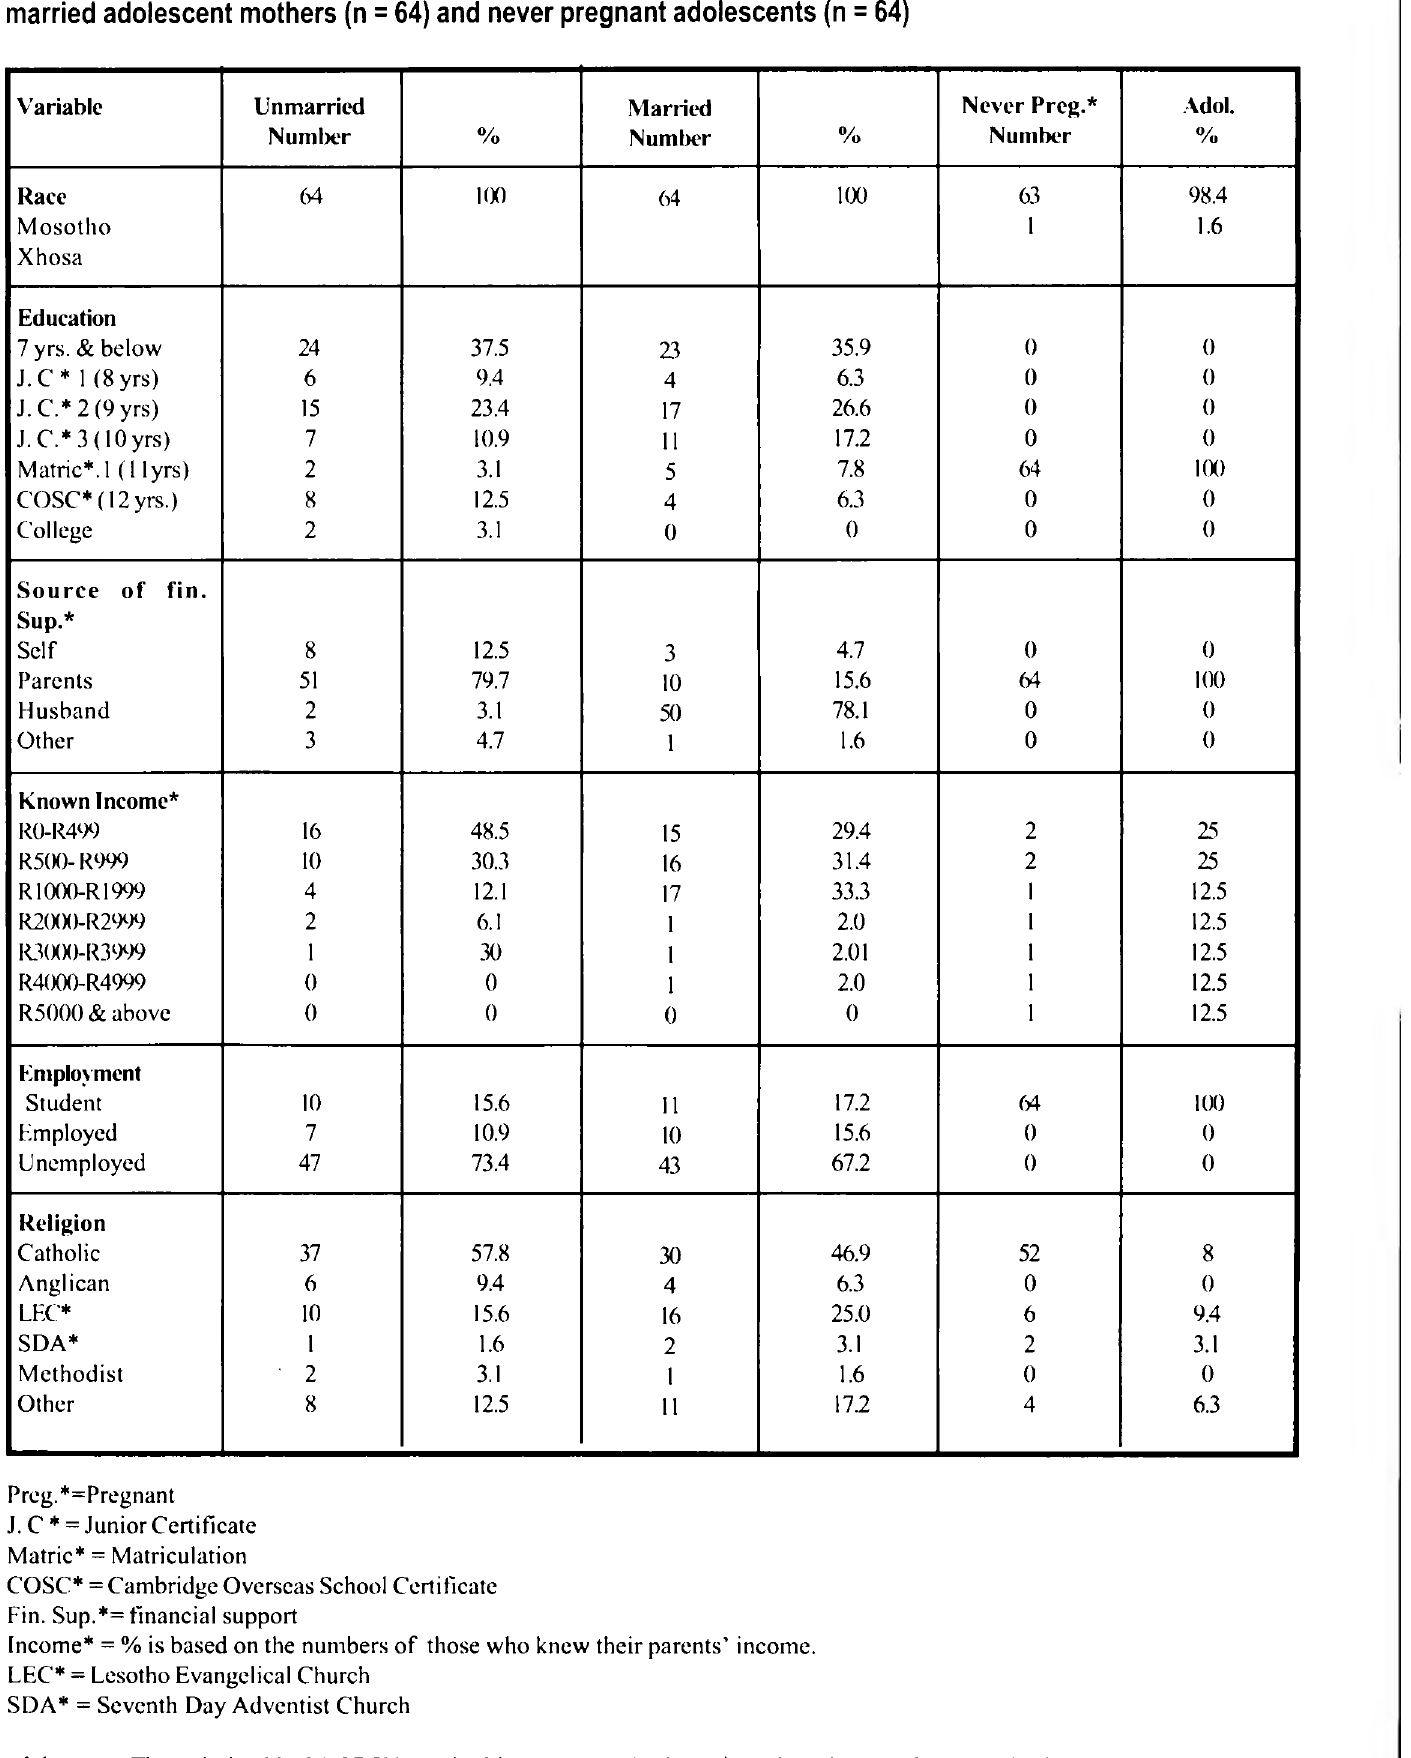
Table 2 Demographic characteristics of unmarried adolescent mothers (n = 64) married adolescent mothers (n = 64) and never pregnant adolescents (n =